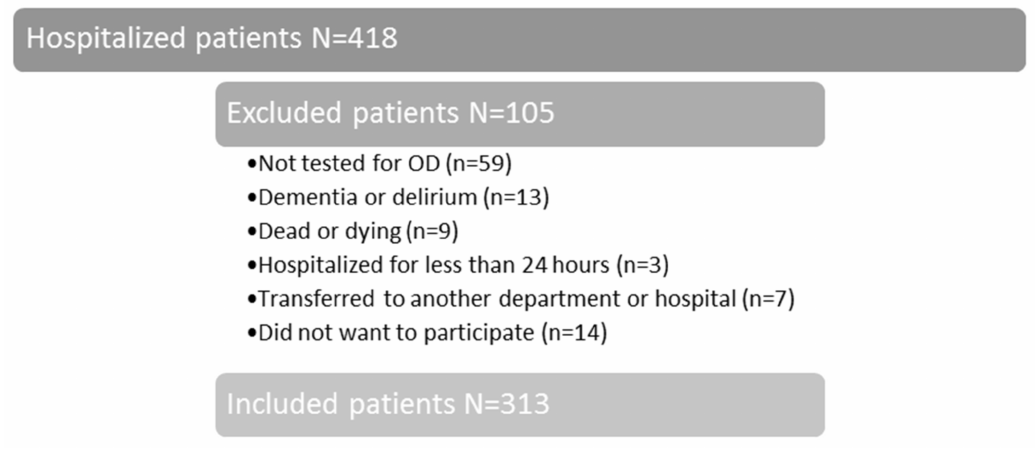
Figure 1. Flowchart over included